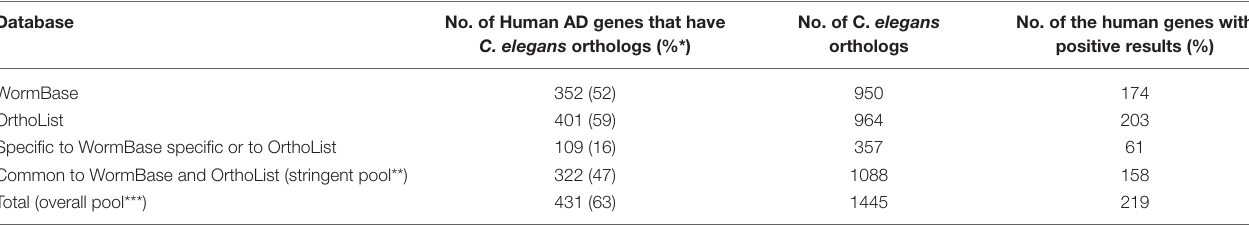
TABLE 1 | Summary of the orthology searches using WormBase and OrthoList.